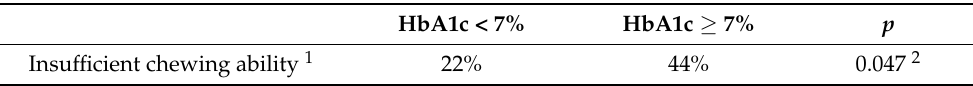
Table 2. Chewing ability and